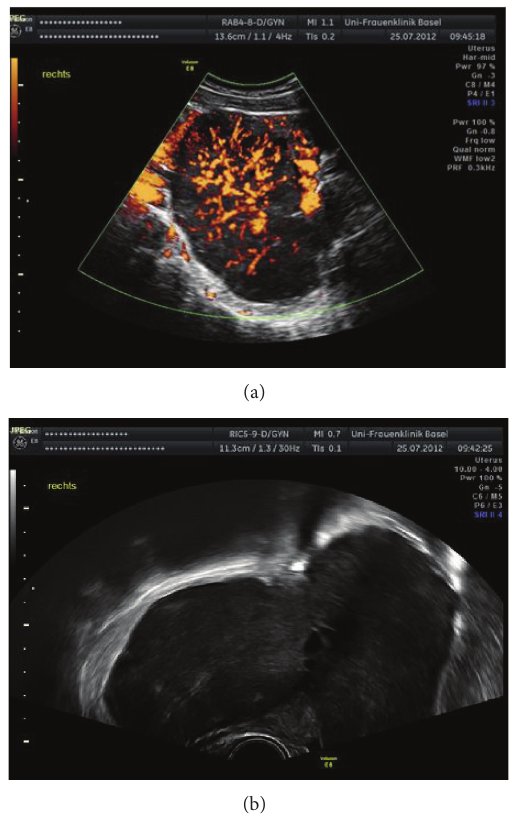
Figure 2: Initial ovarian ultrasound showed bilateral ovary masses.